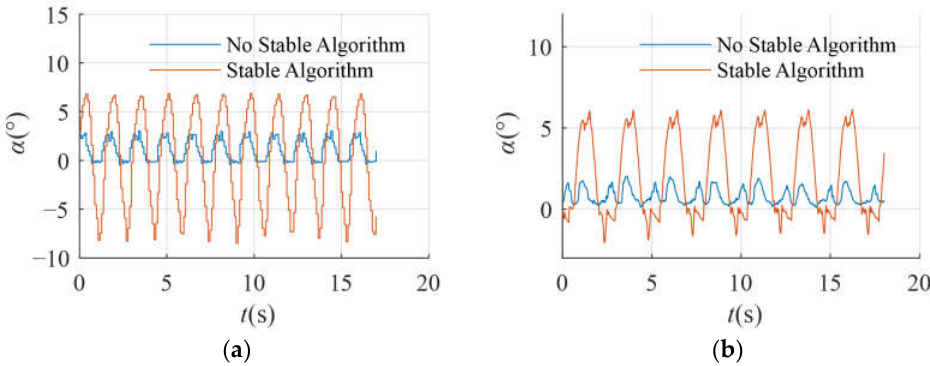
Figure 17. Comparing with and without stable algorithm under simulation and experiment. ( a ) Head pitch angle with and without stabilization algorithm under simulation; ( b ) head pitch angle with and without stabilization algorithm under experiment.